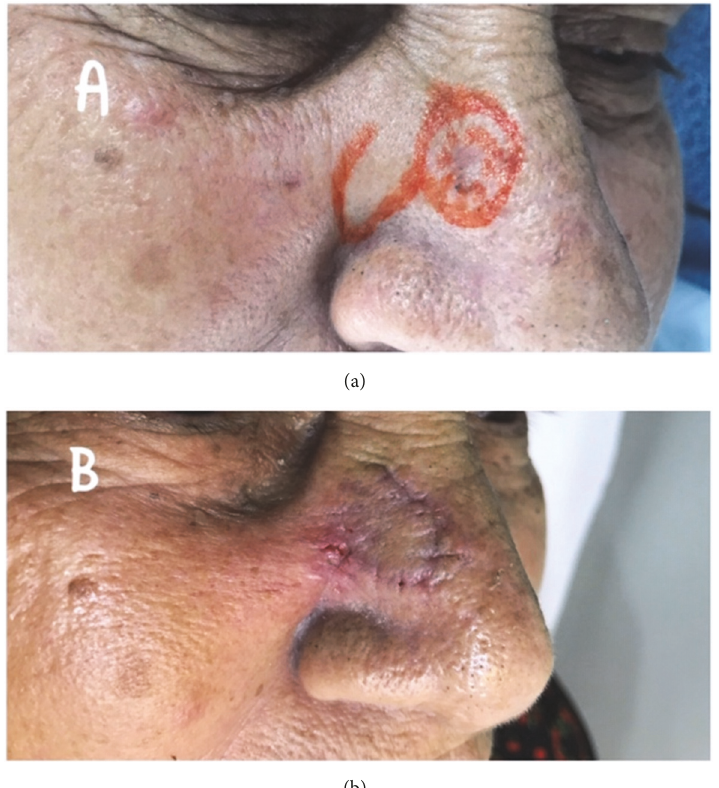
Figure 1: Nasal BCC, after previous marking of dermatoscopy and margin borders (a), and closure with a neighboring flap in transposition. (b) Result with 7 days of